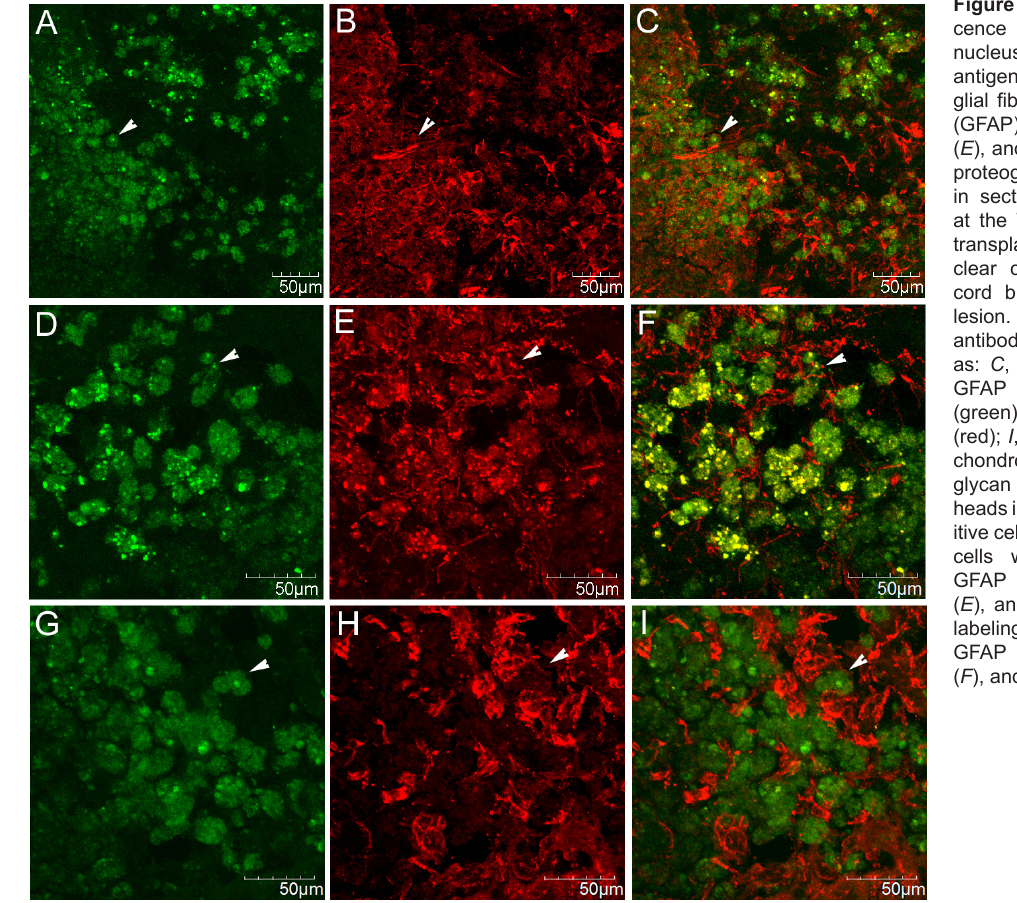
Figure 3. Identification of transplanted cells expressing human-specific anti-nucleus and mitotic cell antigen (NUMA). Mononuclear cells from human umbilical cord (arrowheads) present at the lesion site, at the T9 level, administered into the injury site 1 h ( A ) and into the cistern magna 9 days ( B ) after the